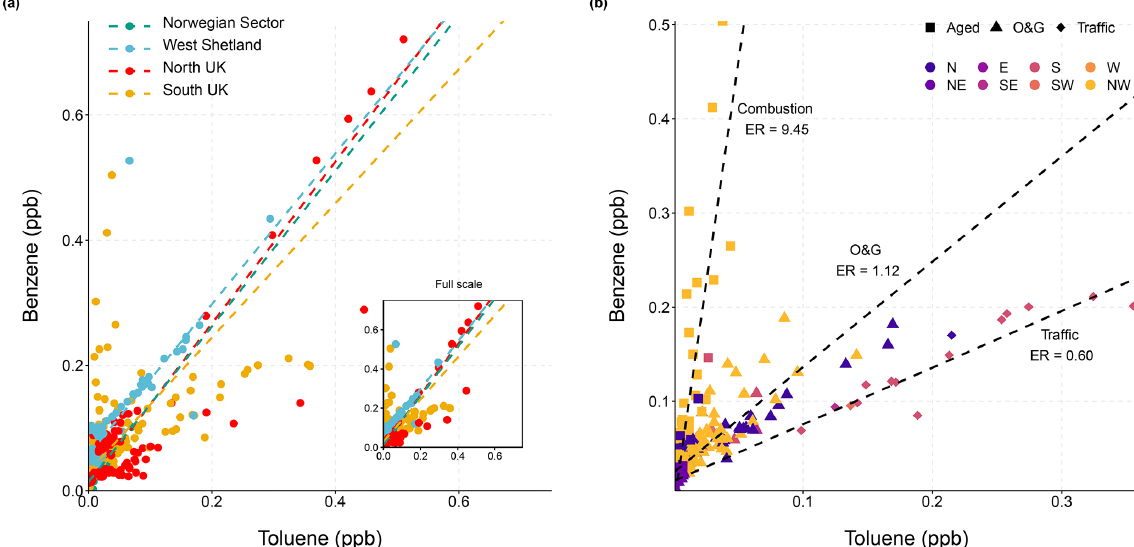
Figure 4. (a) Scatter plot of benzene versus toluene for all sampling regions. Inset shows the full scale of observations. (b) The southern UK only, where the colour represents the average wind sector during the time the sample was taken and the shape represents identified emission sources. In both figures the dashed lines indicate the linear fit obtained by reduced major-axis regression.